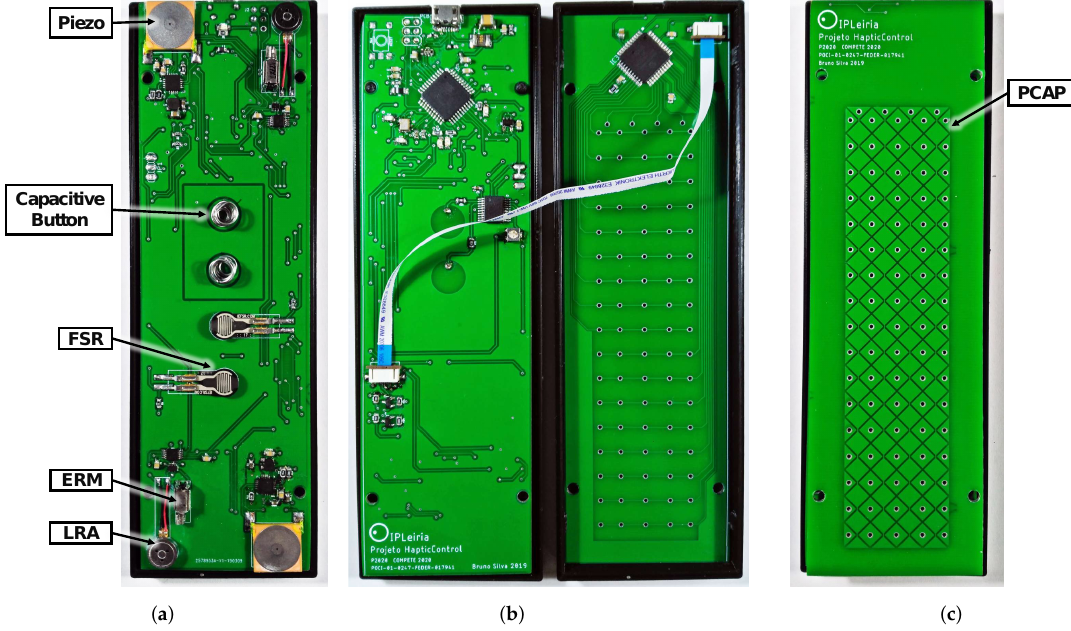
Figure 1. Developed prototype; ( a ) Top layer of module A; ( b ) Bottom layer of the module A (left) and top layer of module B (right); ( c ) Bottom layer of module